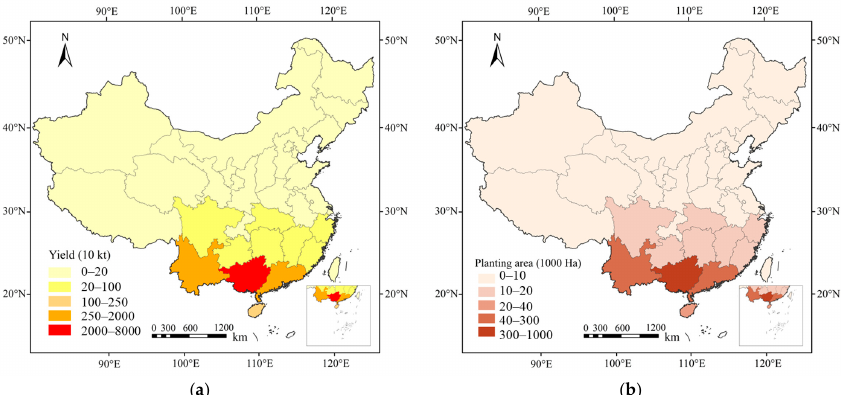
Figure 1. Basic information on Chinese sugarcane production over the last decade. ( a ) and ( b ) refer to sugarcane yield (10 kt) and planting areas (1000 ha), respectively.